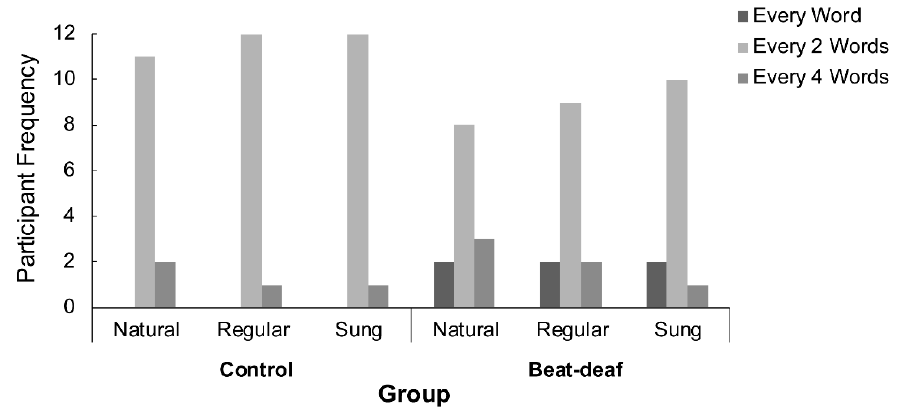
Figure 5. Number of participants in each group who tapped at every word, every two words, or every four words, according to each sentence condition (natural, regular, or sung).